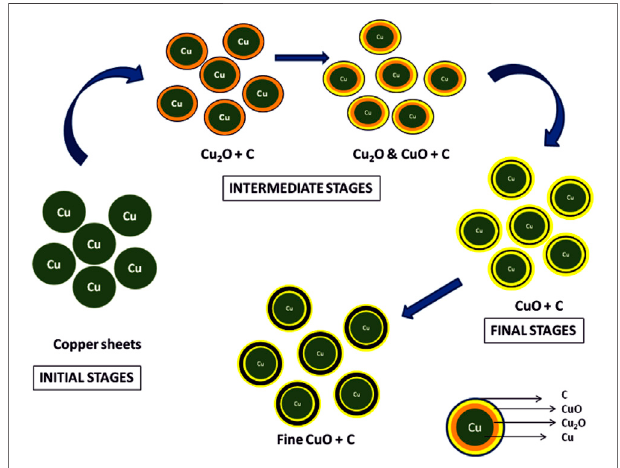
FIGURE 16 | Illustration of stepwise formation of CuO involved in Thamira parpam preparation using the traditional ancient method.